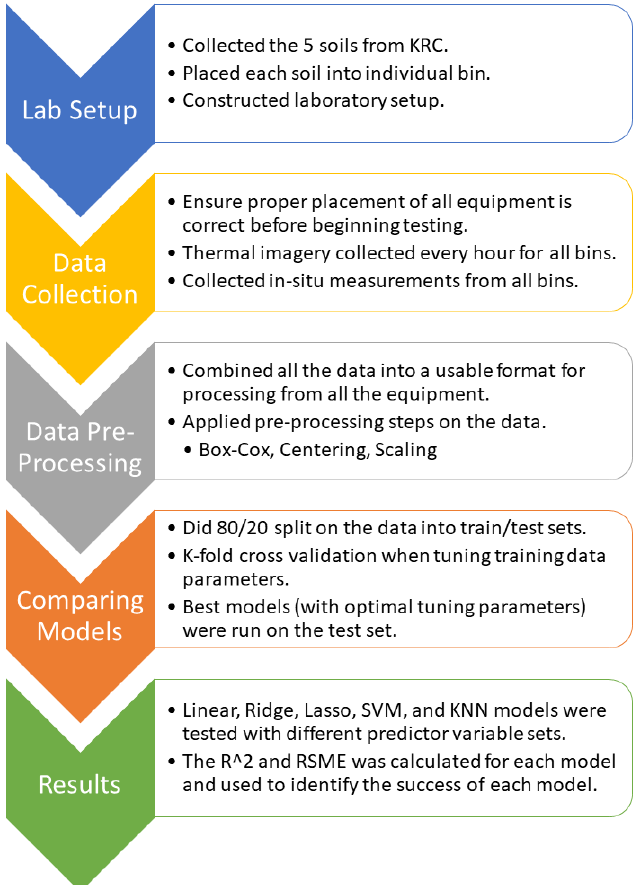
Figure 2. Overview flowchart of the laboratory study process from beginning to end.